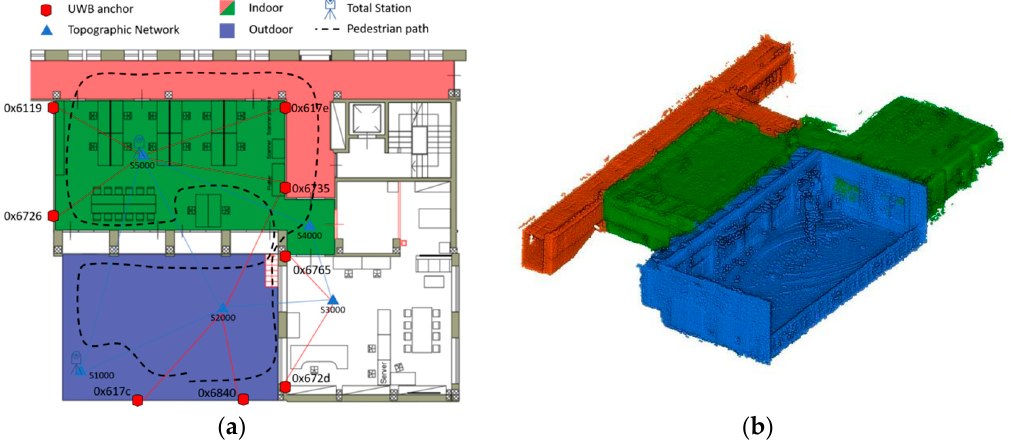
Figure 2. ( a ) Graphical representation of the test with the pedestrian path moving from an outdoor space to an indoor environment. The topographic network, the ultra-wideband (UWB) anchors location and the total stations position are also shown. ( b ) 3D visualization of the outdoor (blue) and indoor (green + red) environments.